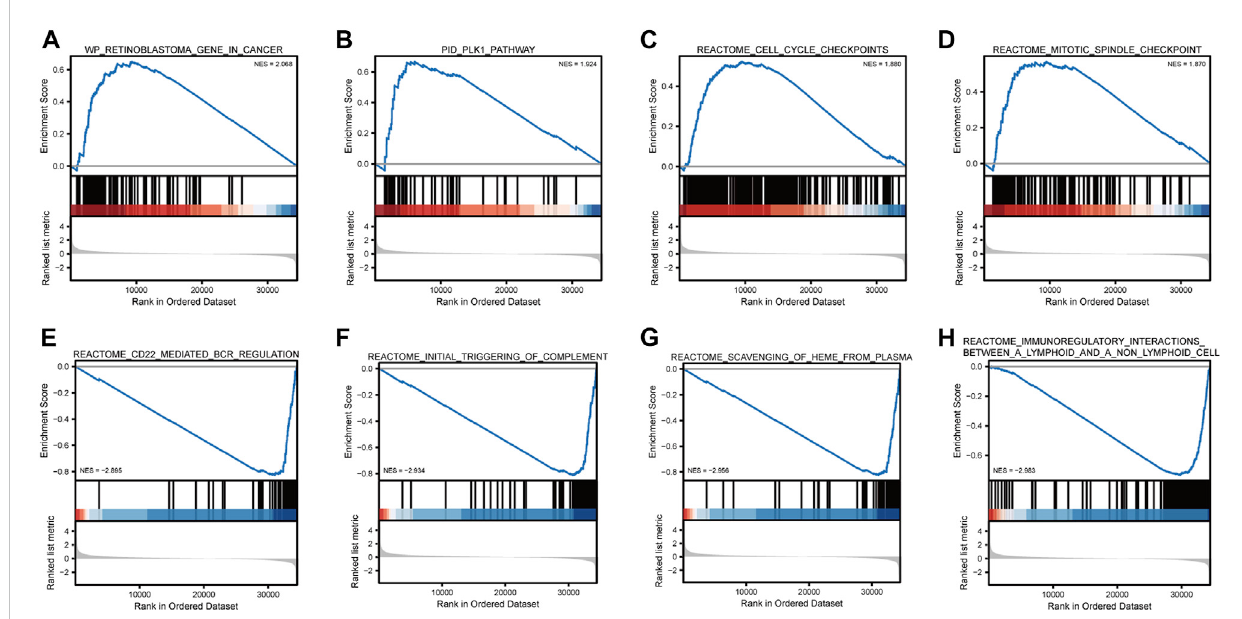
FIGURE 10 Gene set enrichment analysis. Breast cancer is mainly enriched in WP retinoblastoma gene in cancer (A) , PID PLK1 pathway (B) , reactome cell cycle checkpoints (C) , reactome mitotic spindle checkpoint Biocarta MCM pathway (D) , reactome CD22-mediated BCR regulation (E) , reactome initial triggeringofcomplement (F) ,reactomescavengingofhemefromplasma (G) ,andreactomeimmunoregulatoryinteractionsbetweenlymphoidandnon- lymphoid cells (H)